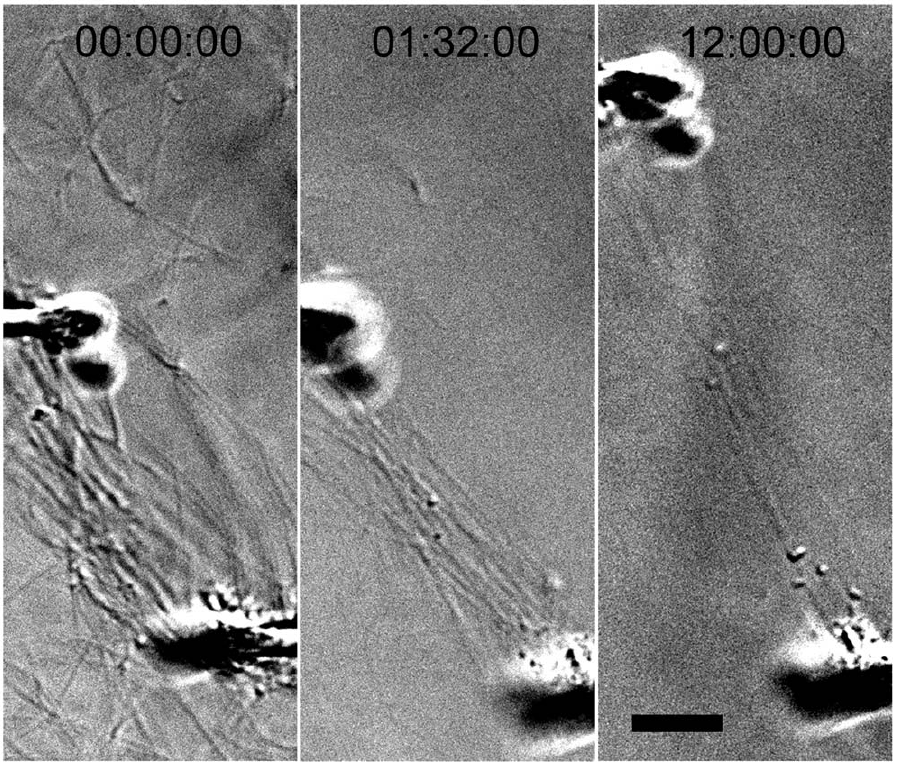
Figure 2. DIC image showing pipette drift stretching fibrils to over 100% initial length during enzymatic degradation. Experimental time series images show the micropipettes drifting 30–40 m m apart, without fracturing or significantly thinning attached collagen fibrils, indicating either additional collagen deposition or structural changes within the fibrils. Note, in the last frame, stretched fibrils remain visible in the microbioreactor while peripheral fibrils have degraded. Experiments with large pipette drift were excluded from analysis. Bar =10 m m. doi:10.1371/journal.pone.0012337.g002 telopeptides, and resulting decrease in packing order, should conservative. It is unlikely that reduced fibrillar packing order increase susceptibility of fibrils to collagenolysis. Additionally, decreases the MMP susceptibility of collagen fibrils. Relevance: possible molecular sliding induced by the application of strain Though intact telopeptides reduce the collagenolytic rate of MMP, could further expose individual molecules, making the results